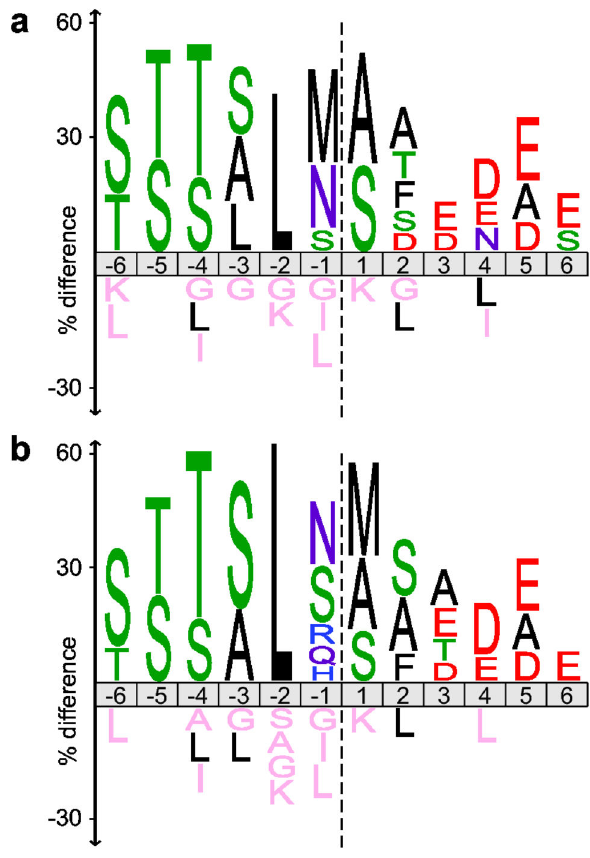
Figure 4. Amino acid occurrences at the transit peptide cleavage